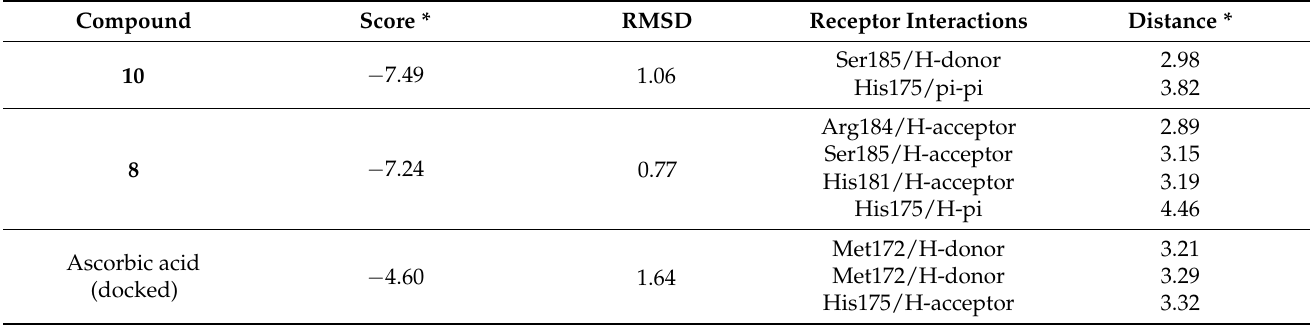
Table 2. The binding scores, RMSD values, and receptor interactions of the two most promising compounds ( 10 and 8 ) compared to the docked ascorbic acid as a reference standard inside the binding pocket of cytochrome c peroxidase. Compound Score * RMSD Receptor Interactions Distance * 10 − 7.49 1.06